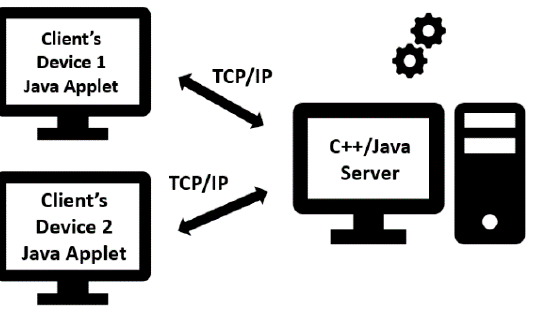
Figure 2. Communication client-server based on a Java Applet to show Pareto frontiers.